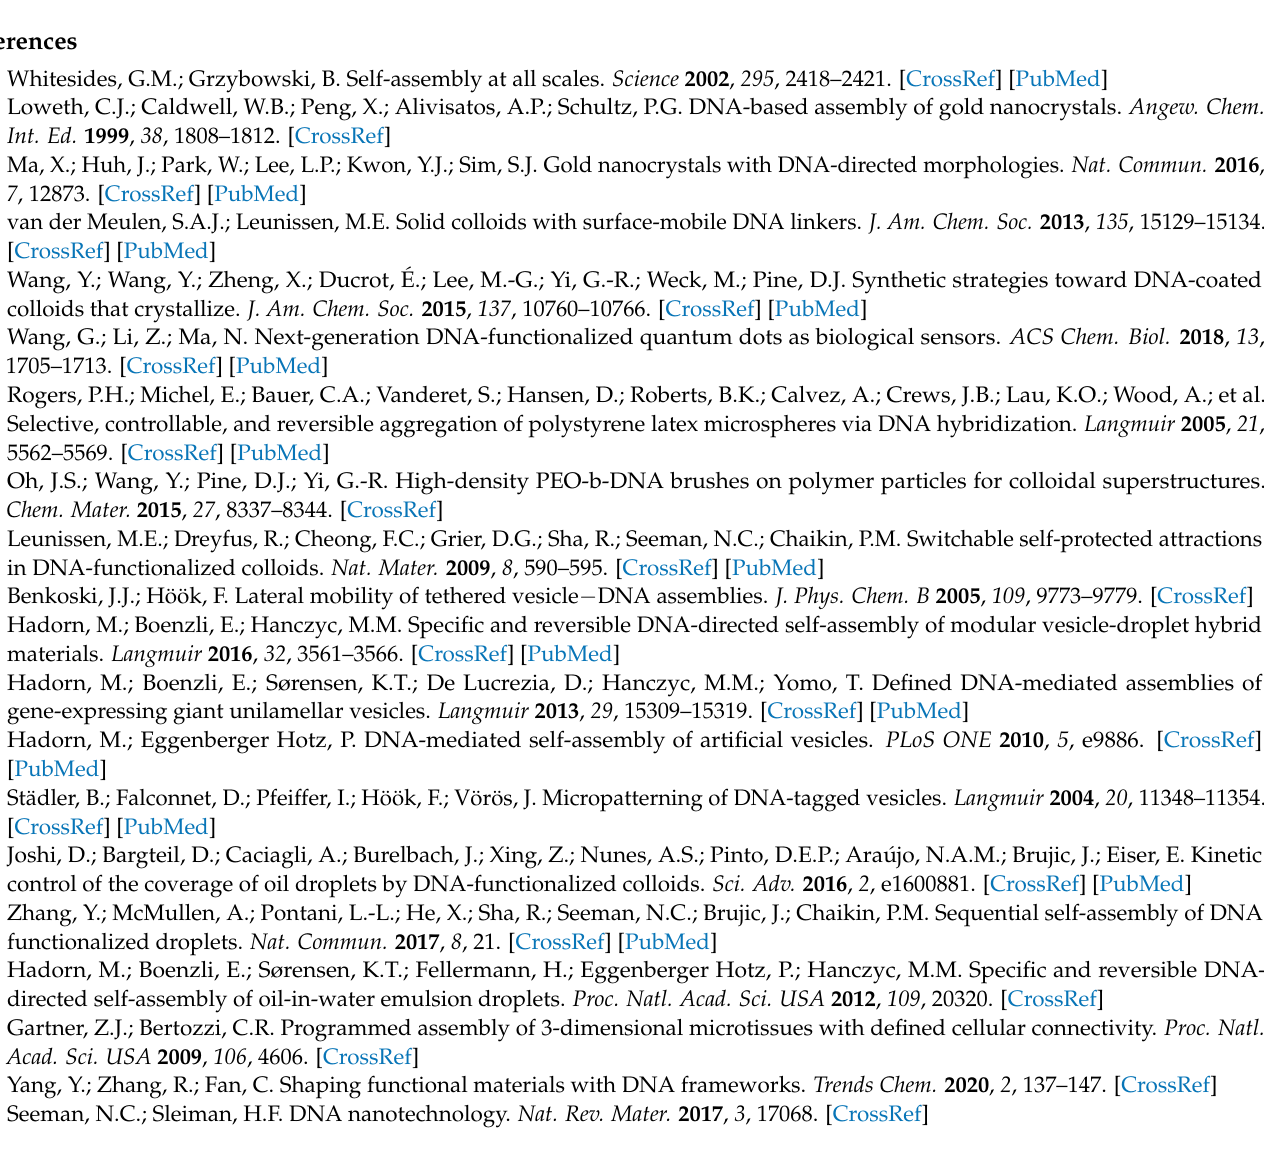
Figure S5: The Au substrate modified by C-SH-DNA and NC-DNA-SH after heating and washing, which can be utilized to adsorb LC droplets at least 3